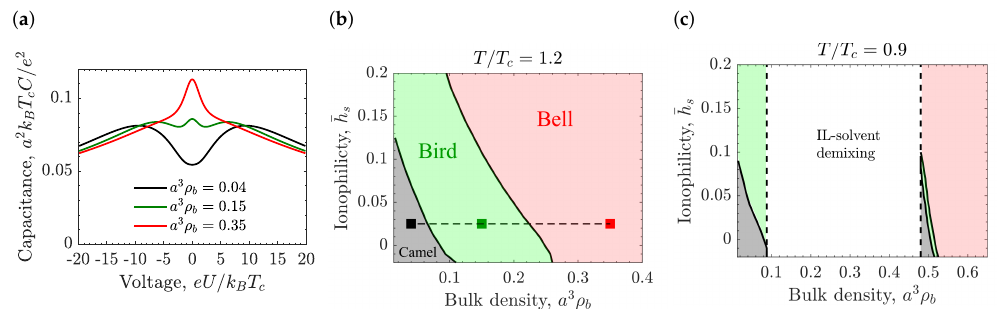
Figure 5. Differential capacitance close to demixing at constant temperature. ( a ) Differential capaci- tance for the Carnahan–Starling (CS) approximation as a function of applied potential at constant temperature, T / T c = 1.2, ionophilicity ¯ h s = a 3 h s / ξ 0 = 0.025, and three different bulk densi- ties, demonstrating the camel-, bird-, and bell-shaped capacitance. ( b ) Capacitance diagram for the Carnahan-Starling (CS) approximation showing the regions of camel, bird, and bell-like ca- pacitance at constant temperature, T / T c = 1.2. The dashed horizontal line denotes the value of ¯ h 3 h s = a s / ξ 0 = 0.025 and the symbols mark the bulk densities ρ b used in panel ( a ). ( c ) Capaci- tance diagram for the Carnahan-Starling (CS) approximation showing the regions of camel, bird, and bell-like capacitance for temperature below T c , T / T c = 0.9. The white region denotes the domain of the IL-solvent demixing (Figure 4a). For common values of the ion diameter a = 0.7nm and room temperature for T c , the various units are: thermal voltage e / k B T c ≈ 26mV for voltage,